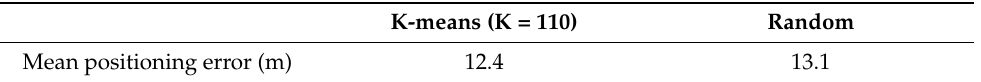
Table 9. Comparison of validation sets obtained by different methods on the UJIIndoorLoc dataset.